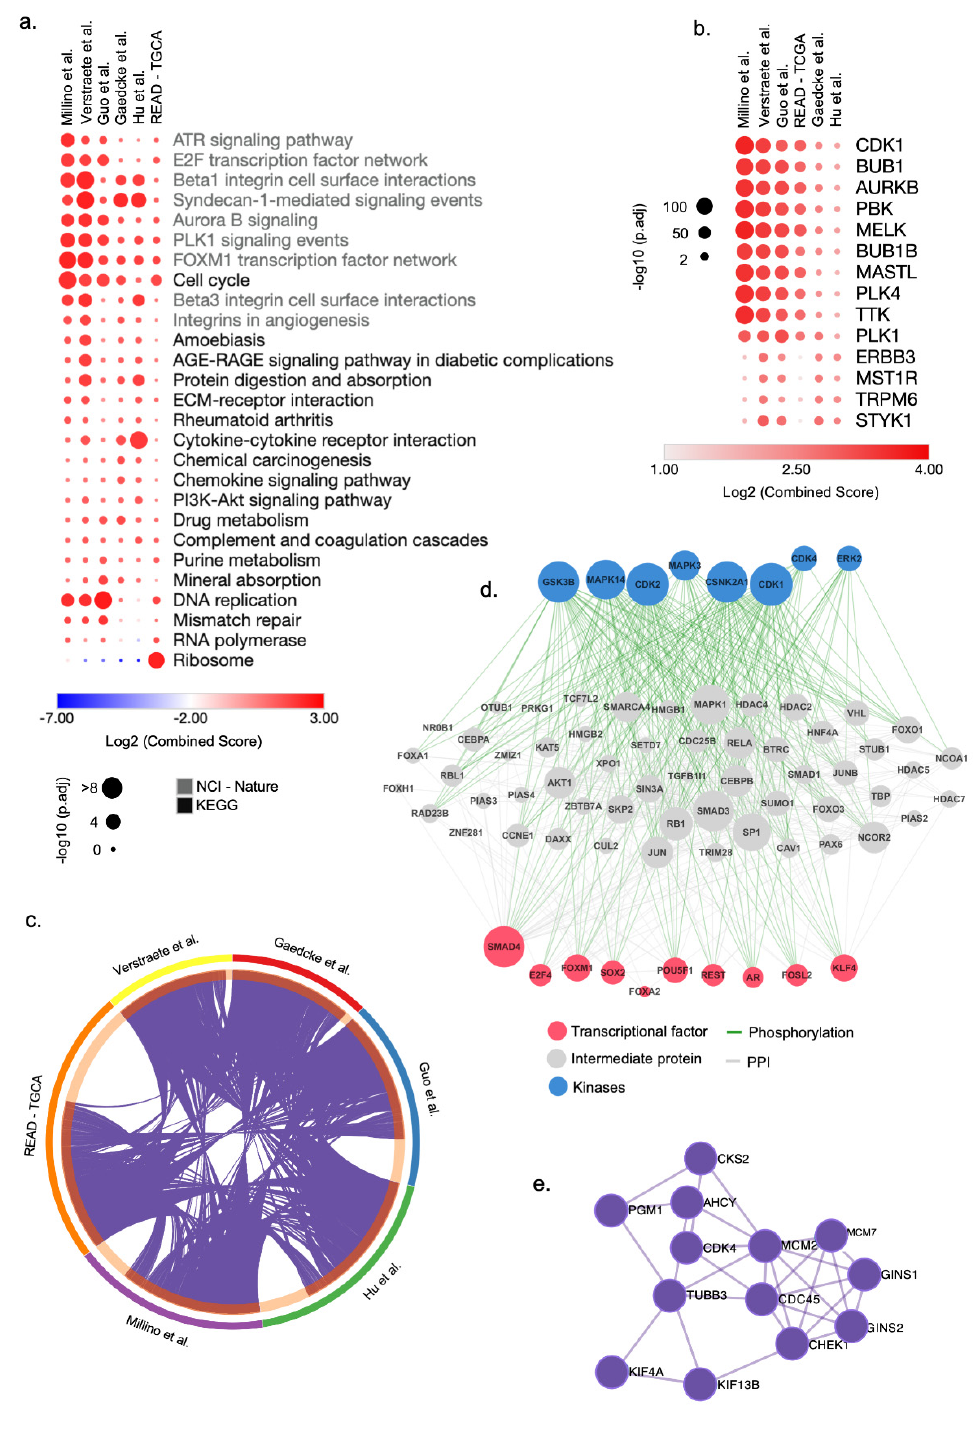
Figure 2. Integrative transcriptomic analysis reveals cell cycle genes as potential drug targets for rectal cancer (ReCa). ( a ) Top-ranked combined scores for The Kyoto Encyclopedia of Genes and Genomes (KEGG) and NCI-Nature 2016 pathway categories determined by the gene set enrichment analysis tool EnrichR [51,52]. The top five pathways for each category were included in a consensus list when satisfying the criteria of over-representation (Adjusted p -value < 0.05) in at least one signature. Columns and rows were clustered based on the Euclidean distance of log2 combined score values. ( b ) Top- ranked combined scores for kinase genes co-expressed with each ReCa signature in the ARCHS4 [76] database determined by the gene set enrichment analysis tool EnrichR [51,52]. The top five gene set enrichment terms were included in a con- sensus list when satisfying the criteria of over-representation (Adjusted p -value < 0.05) in at least one signature. Columns and rows were clustered based on Euclidean distance of log2 combined score values. ( c ) Circos plot visualization of the differentially expressed genes (DEG) that overlap among the ReCa signatures: Gaedcke et al., GSE20842 [75]; Guo et al.,